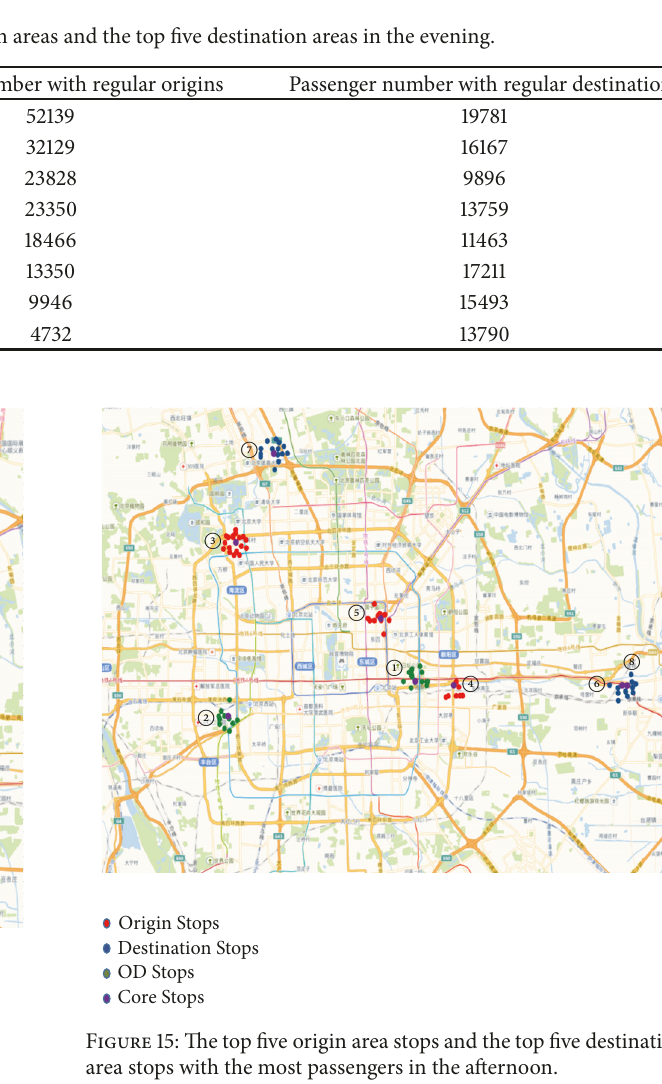
Figure 14: Thetop five origin areas and the topfive destinationareas with the most passengers in the morning.